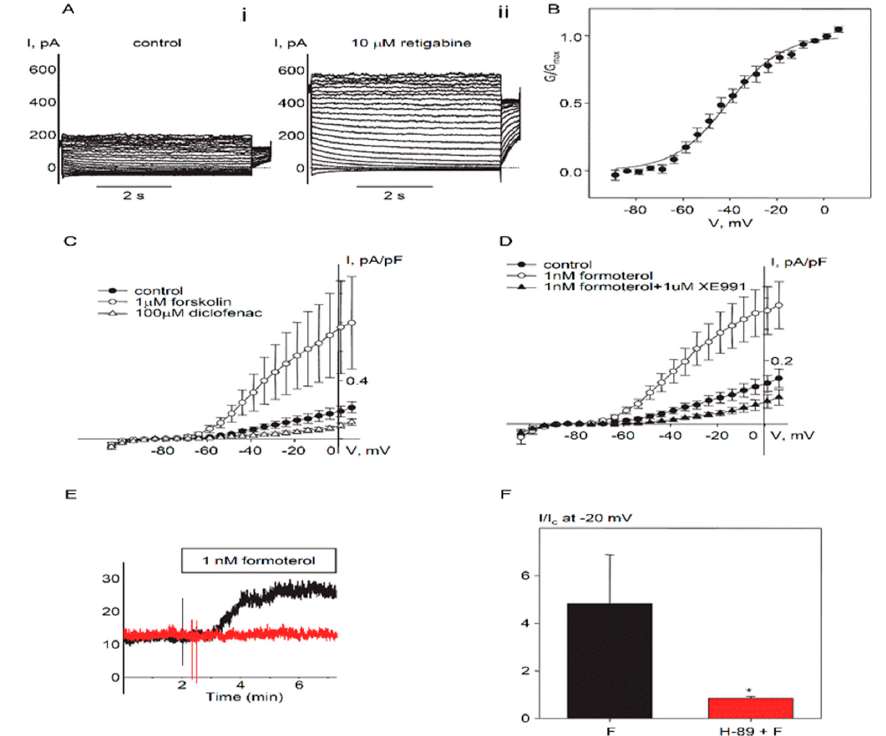
Figure 2. Protein kinase A (PKA)-dependent regulation of endogenous Kv7.5 currents in cultured HASMCs. ( A ) Representative current traces recorded in a single HASMC (Capacitance = 281 pF) before (i. control) and 5 min after addition of 10 µM retigabine (ii). ( B ) Mean fractional conductance plot calculated from steady-state endogenous Kv7 currents fitted to a Boltzmann distribution (V 0.5 = − 40.8 mV, n = 10). ( C ) I–V relationships of Kv7 currents recorded in HASMCs before (control, filled circles, n = 5), after 5 min treatment with 1 µM forskolin (open circles, n = 4), and after 5 min treatment with diclofenac (100 µM, open triangles, n = 4). ( D ) I–V relationships of Kv7 currents recorded in HASMCs before (control, filled circles, n = 7), after 5 min treatment with 1 nM formoterol (open circles, n = 7), and after 5 min treatment with Kv7 channel blocker XE991 (1 µM) in the presence of 1 nM formoterol (closed triangles, n = 3). ( E ) Representative time-courses of 1 nM formoterol application recorded at − 20 mV in a single untreated HASMC (black, Capacitance = 39 pF) and a HASMC pretreated with 10 µM H-89 (red, C = 127 pF). ( F ) Relative formoterol-induced enhancement of the current recorded at − 20 mV in untreated HASMCs (black bars, n = 7) and in HASMCs pretreated with H-89 (10 µM for 20 min, red bar, n = 4). * Significant difference from control ( p < 0.01, Mann-Whitney Rank Sum Test).